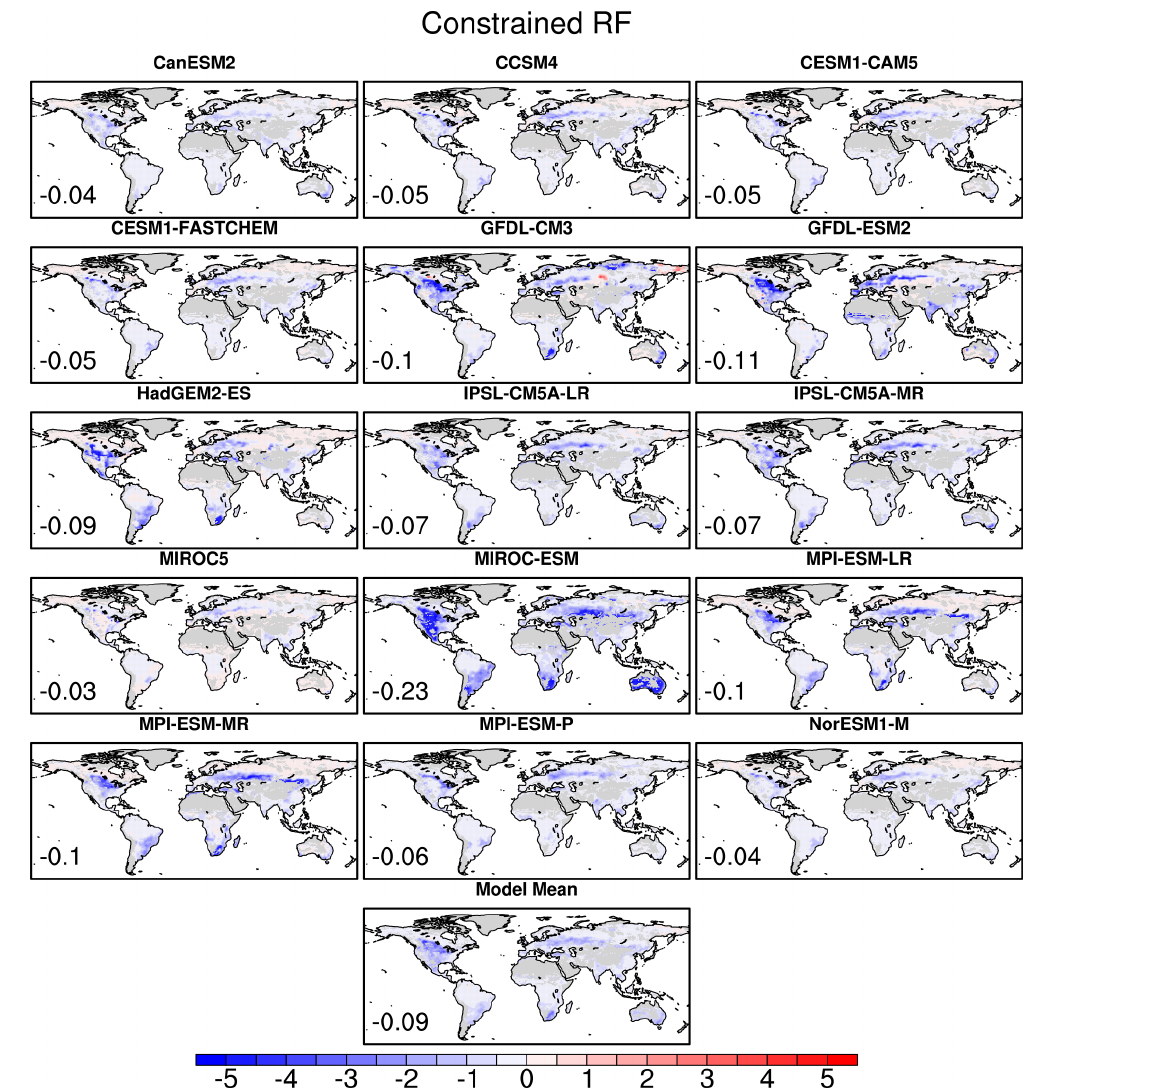
Figure 13. Same as Fig. 12, but for the observation-constrained radiative forcing from historical conversions between trees and crops–